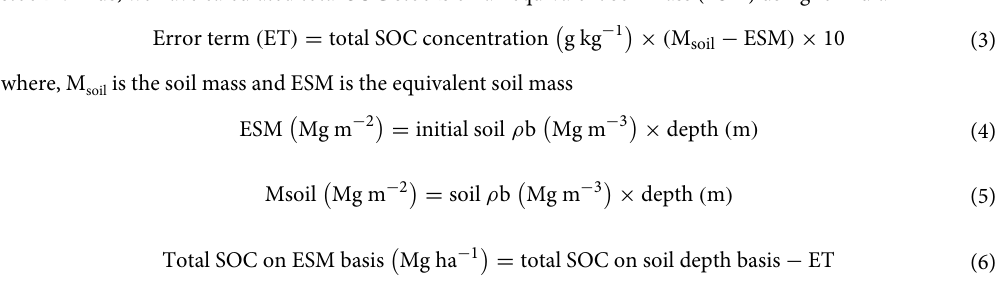
To prevent bias due to variation in soil ρ b (Mg m −3 ) and take into full account the effect of soil mass on SOC stock 68 . Thus, we have calculated total SOC stocks on an equivalent soil mass (ESM) using formula 69